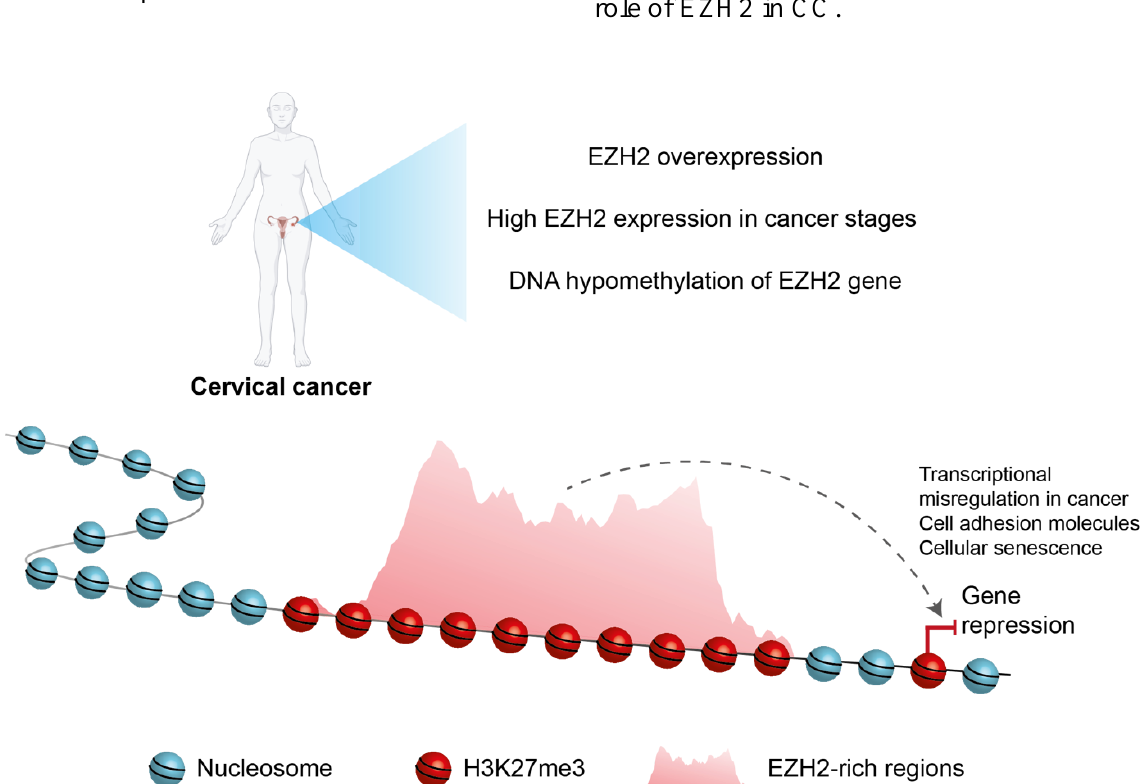
Figure 7: Proposed model for EZH2-rich domains in cervical cancer. EZH2 is overexpressed in CC patients. EZH2 overexpression is associated with DNA hypomethylation of its promoter. EZH2 is en- riched at promoters where it regulates transcriptional repression. Besides, EZH2 generates domains enriched with H3K27me3. These domains are associated with repressive compartments, which allow the silencing of target genes. Finally, EZH2 is associated with the repression of cancer-associated genes in CC, mainly genes associated with cellular